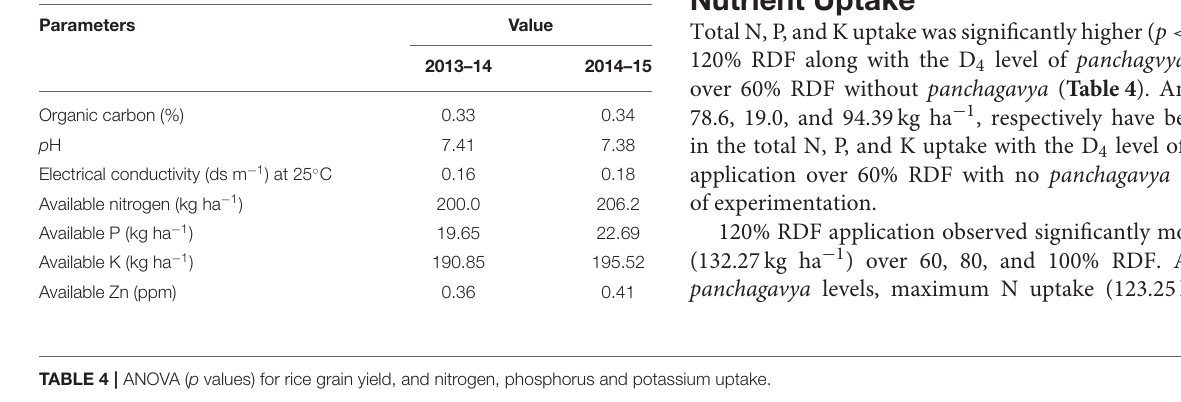
TABLE 3 | Chemical properties of experimental field (initial value). Parameters